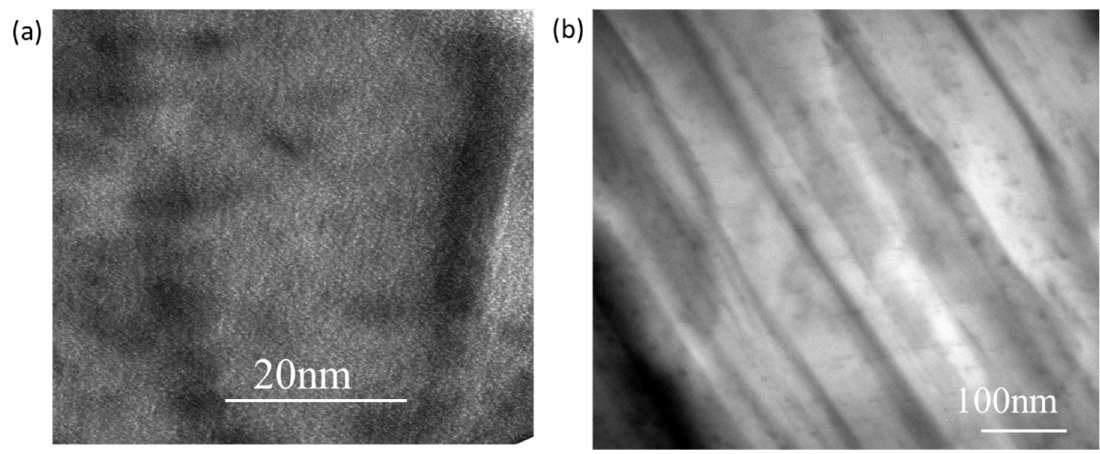
Figure 10. TEM images of the sericite/epoxy nanocomposites (the amount of sericite was 1 wt %). ( a ) scale bar 20 nm; ( b ) scale bar 100 nm.